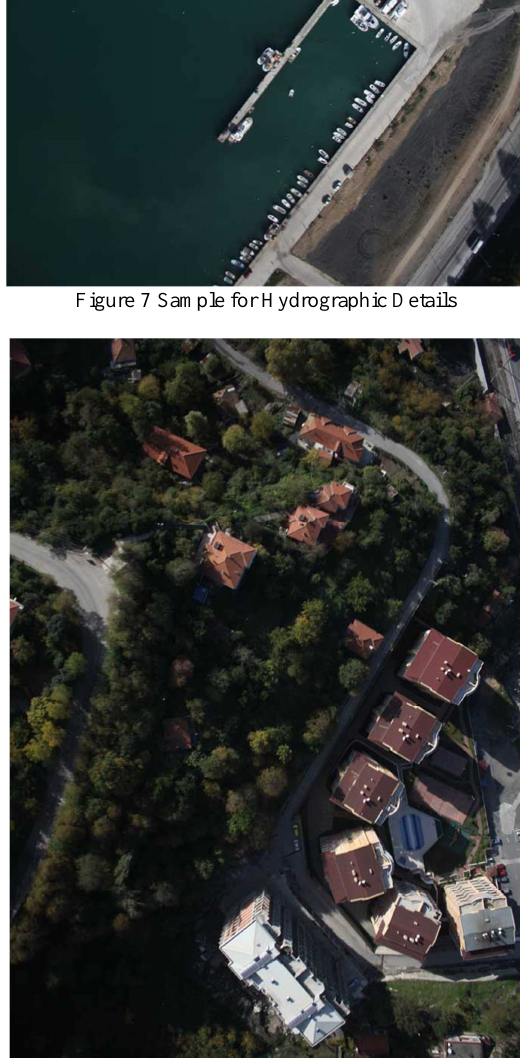
Figure 8 Sample for Urban and Urban Forest